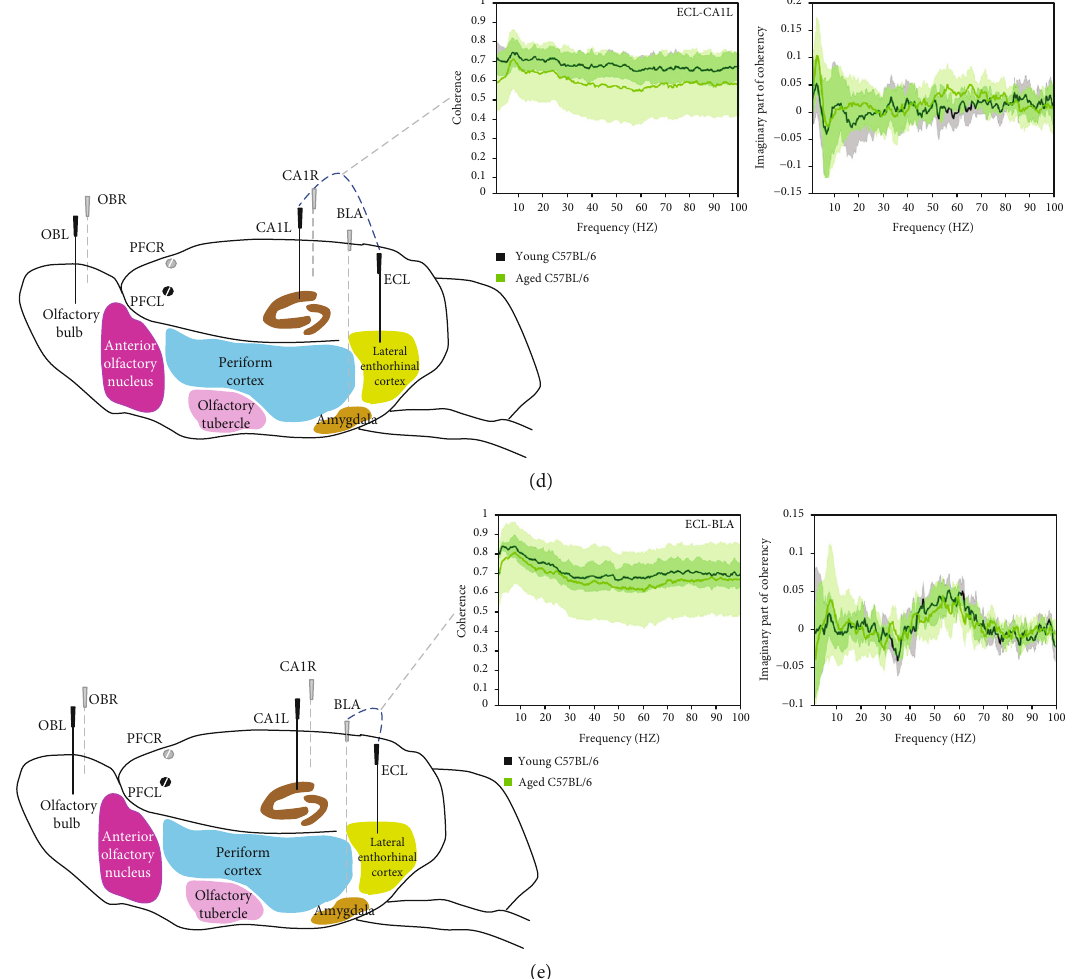
Figure 4: Coherence and imaginary part of coherency patterns between recording pairs (a) olfactory bulb left and right (OBL-OBR), (b) olfactory bulb left and CA1 left (OBL-CA1L), (c) CA1 left and basolateral amygdala (CA1L-BLA), (d) enthorinal cortex left and CA1 left (ECL-CA1L), (e) enthorinal cortex left and basolateral amygdala (ECL-BLA), in young (black, n = 7 ) and aged (green, n = 8 ) C57BL/6 mice. Graphs show mean values ( ± 95% CI) as a function of frequency in 1-100Hz range. Bars on the horizontal axis indicate clusters, which drive signi fi cant between group di ff erences using threshold-free cluster enhancement (TFCE, α = 0 : 05 ). In panel (a), bar and whiskers panels show imaginary part of coherency for interval 25-35Hz. Lines above bar plot with asterisks indicate presence of signi fi cant di ff erence between groups, ∗ p value < 0.05 (two-sample t